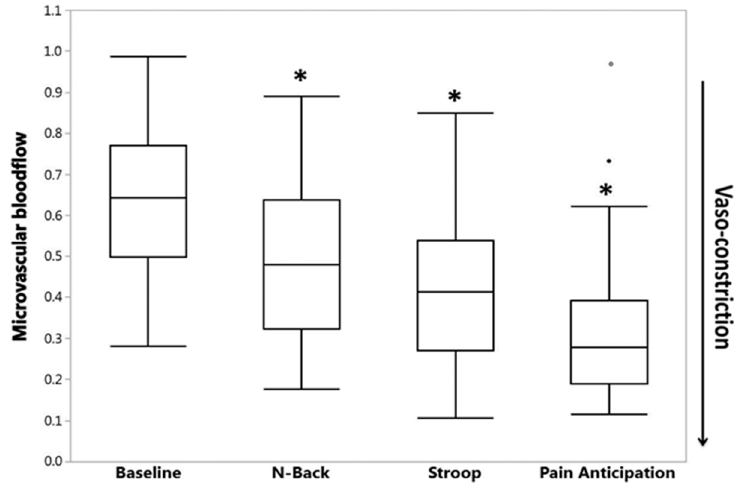
Figure 7. Experimental mental stress causes decrease in microvascular blood flow. However, being told you are going to feel pain is the most powerful stimulus for vasoconstriction (*, p < 0.0001 decrease in median blood flow compared to baseline; the two dots represent outliers). (After [59] with permission).